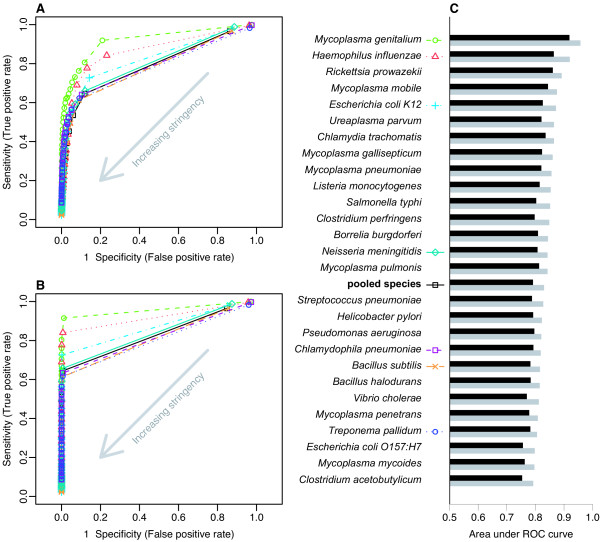
Gene prediction based on sequence conservation. (A) and (B) show receiver-operator characteristic curves summarizing the sensitivity and specificity of gene prediction based on COG membership when compared to the current gene annotations. In (A), an ORF is classified as a gene if it is conserved in a COG at a certain stringency; for (B), the ORF must be in a COG that contains at least one annotated gene from another species. Curves are produced by examining COGs at different stringencies. At stringency 2, tests are very sensitive but not very specific (points at upper right of each panel). As stringency increases, specificity increases and sensitivity decreases (indicated by arrow). For clarity, full ROC curves are shown for only seven of the organisms studied, and for the pooled result among all of the organisms studied. The plotting symbols and colors used in (A) and (B) are next to the organism names in (C). (C) shows the areas under the curves in (A) black bars and (B) grey bars. The ROC curve of a perfect test would enclose an area of 1, for a completely arbitrary test the area would be 0.5. The organisms in (C) are ordered by the area under the ROC curve in (B).